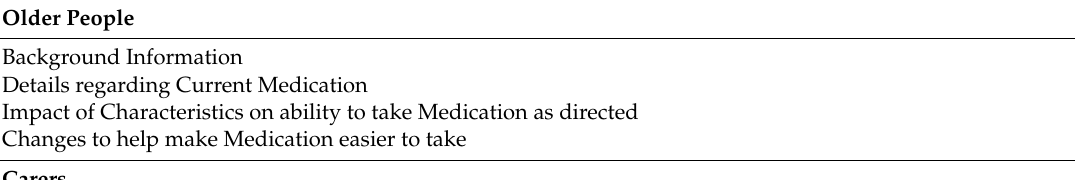
Table 1. Summary of the topic areas explored by the semistructured interview schedule.